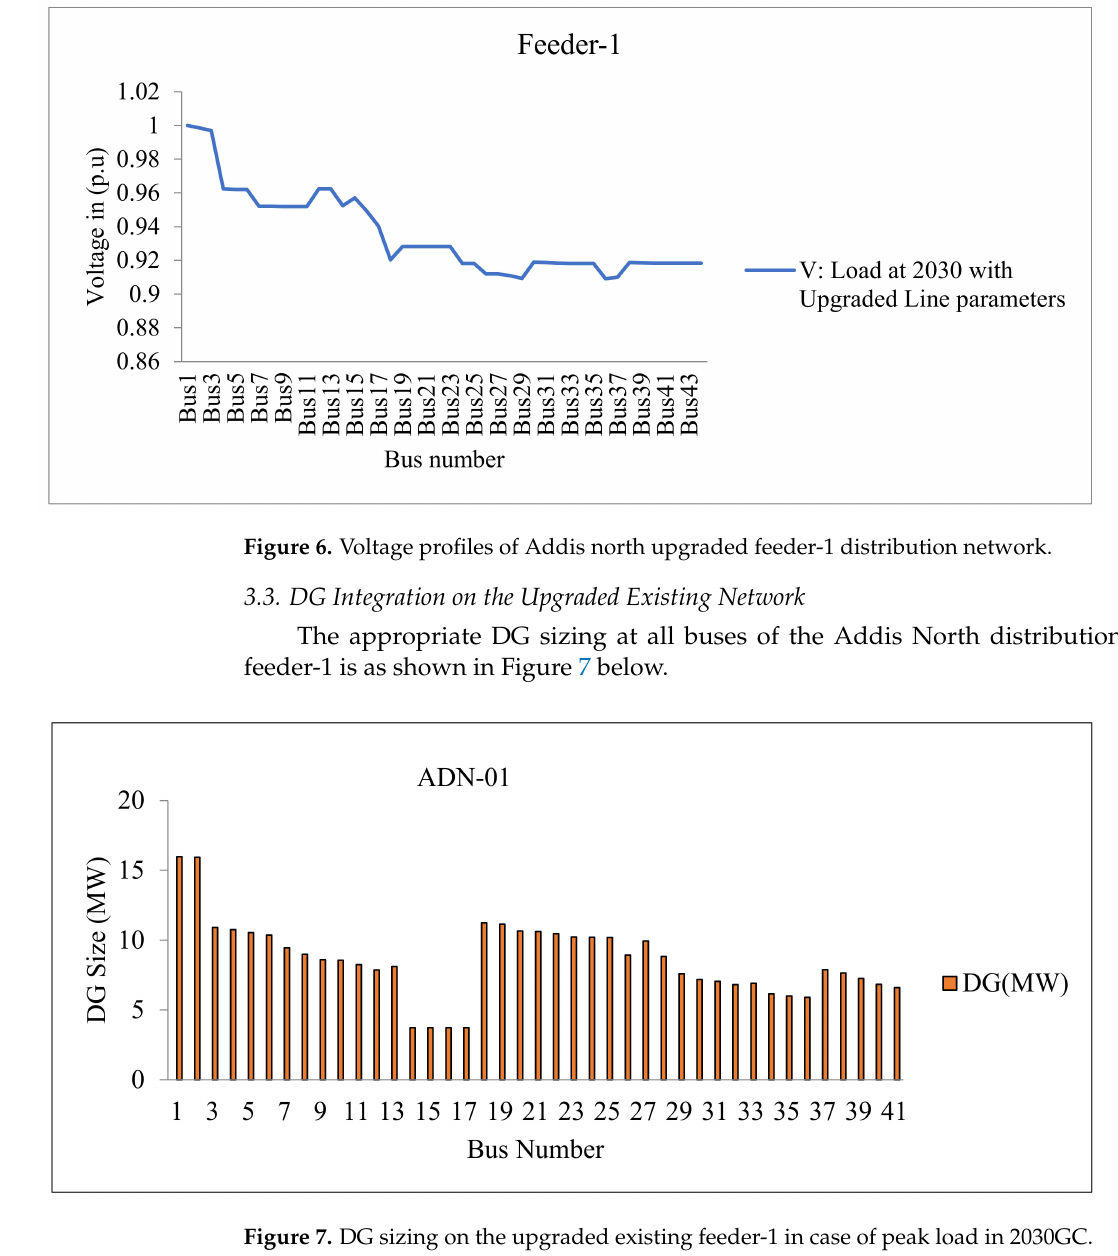
Figure 7. DG sizing on the upgraded existing feeder-1 in case of peak load in